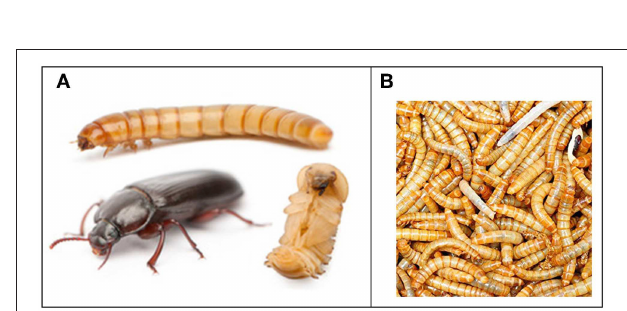
FIGURE 2 | The mealworm Tenebrio molitor . (A) Life cycle showing larva, pupa and adult. Epic mealworms: Weebly page by students M. Downey, L. McFarland, and D. Bergeron, STU bachelor of Education 2014 (EDUC 5473). From Google images (no conditions for copyright published, apparently